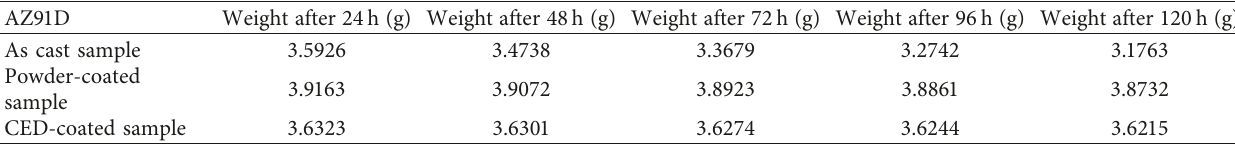
Table 6: Weight reduction of samples after 24h, 48h, 72h, 96h, and 120h.